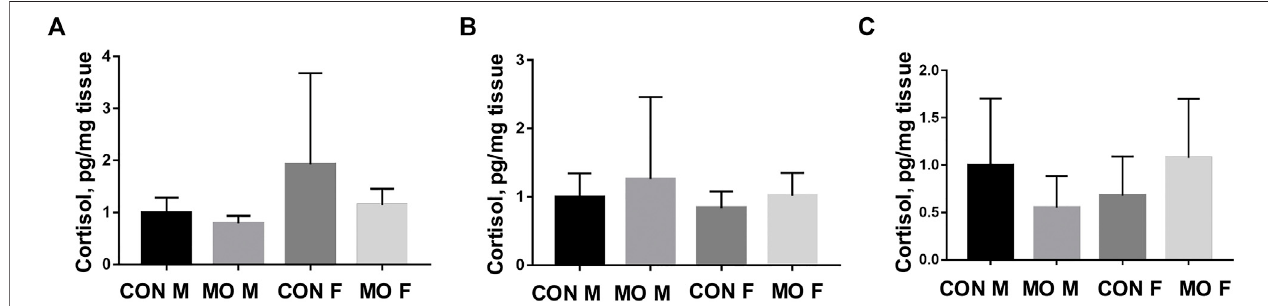
FIGURE 4 | Cortisol concentration in heart tissues of offspring of overfed ewes at two gestational and one early postnatal time point. (A) Cortisol concentration in fetalhearttissuesatday90ofgestation; (B) Cortisolconcentrationinfetalhearttissuesatday135ofgestation; (C) Cortisolconcentrationinneonatalhearttissuesatday 1 after birth; CON, control, MO, maternal obesity, M, male, and F, female. Mean ± SEM ( n (cid:1) 5). No signi fi